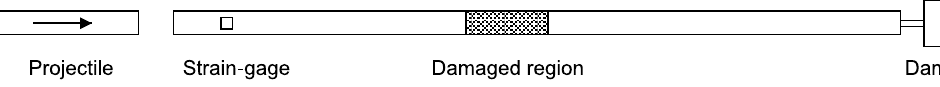
Fig. 1. Damage scenarios imposed to the slender bar.